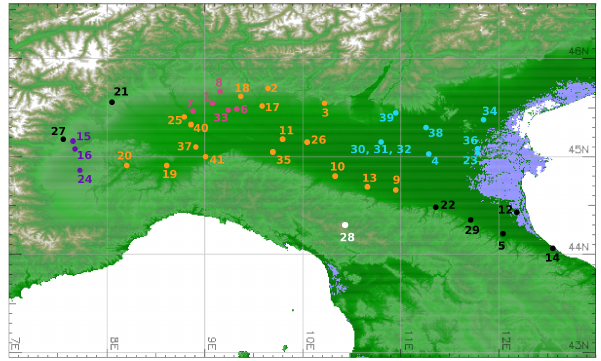
Figure 1. Location of PM 10 monitoring stations included in the analysis. The key for ID number is found in Table 1, the colour cod- ing refers to the result of cluster analysis using Euclidean distance (Fig.